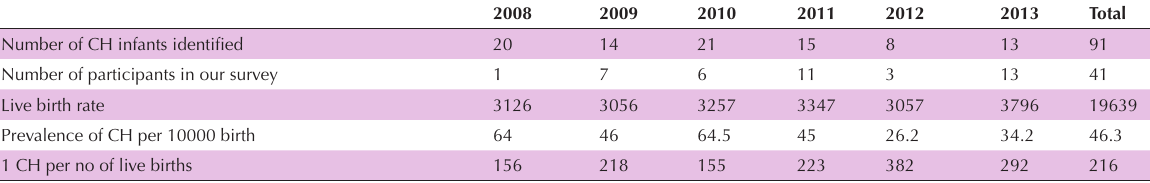
Table 1. The birth rate and prevalence of congenital hypothyroidism in Semnan city, 2008-2013